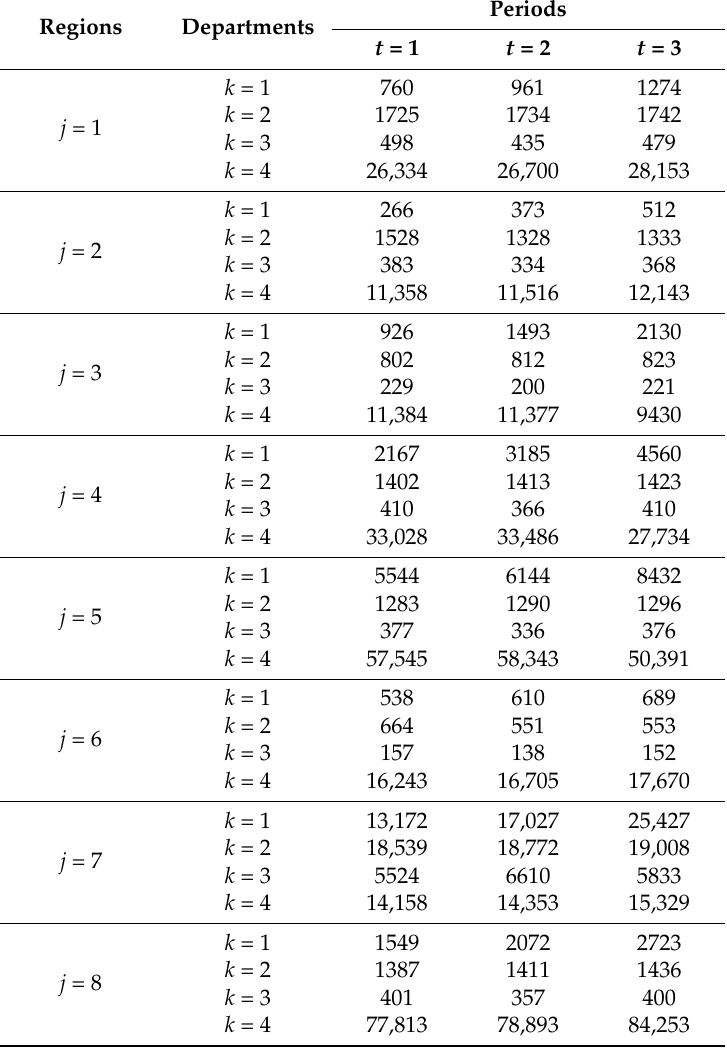
Table 3. Optimal water resource pre-allocations for the Yinma River Basin (10 4 m 3 /year).